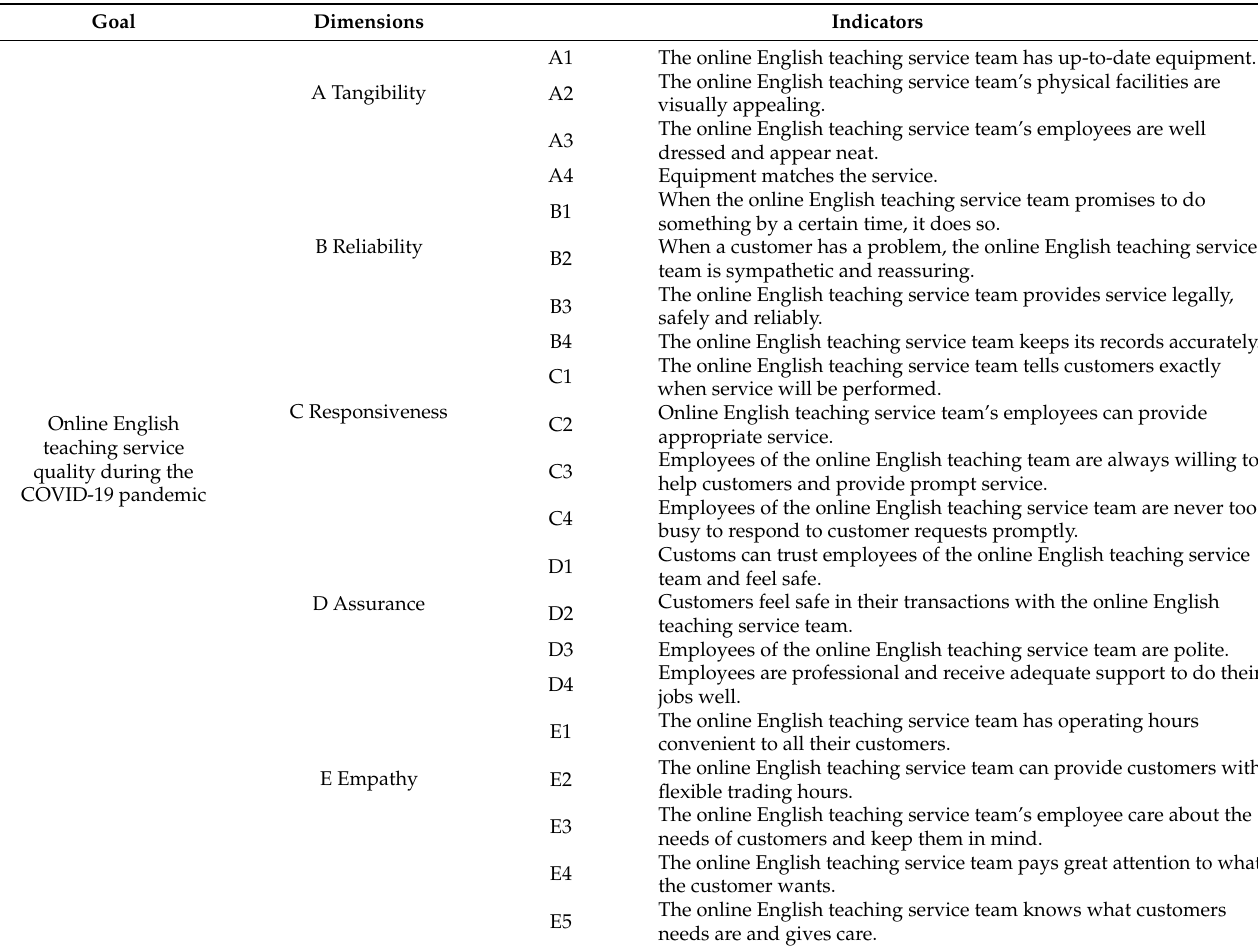
Table 3. Online English teaching service quality evaluation